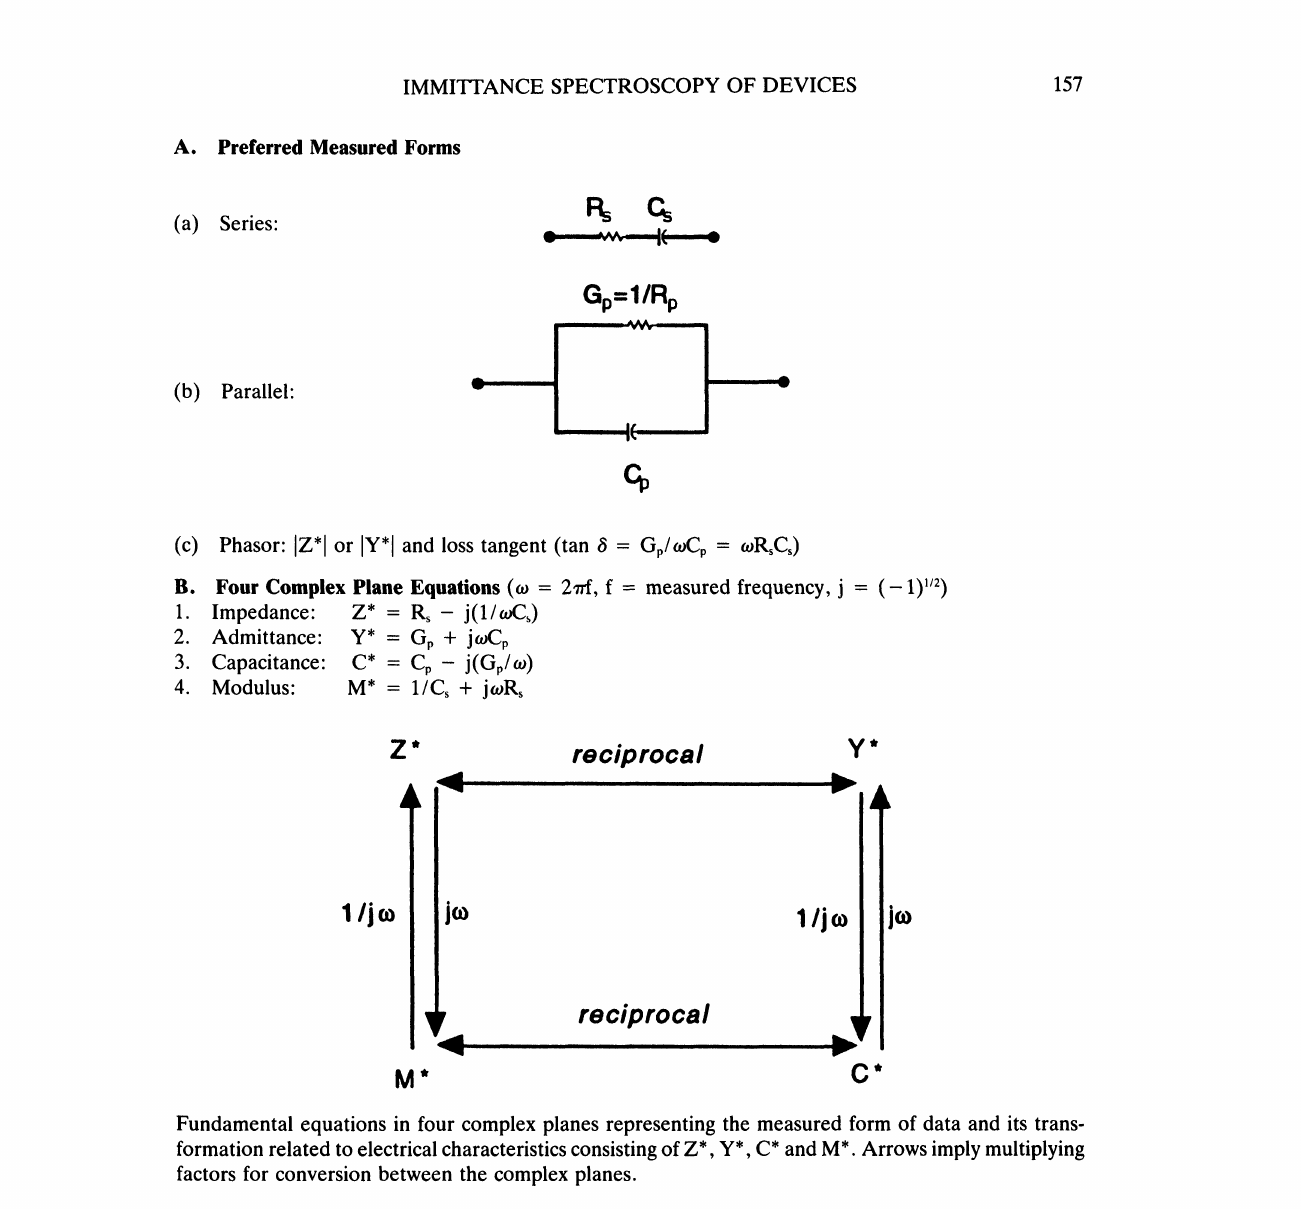
Fundamental equations in four complex planes representing the measured form of data and its trans- formation related to electrical characteristics consisting of Z*, Y*, C* and M*. Arrows imply multiplying factors for conversion between the complex planes. FIGURE 2 Choice of measured forms of the acquisition of the ac small-signal electrical data and inter-convertible relationships within the four complex